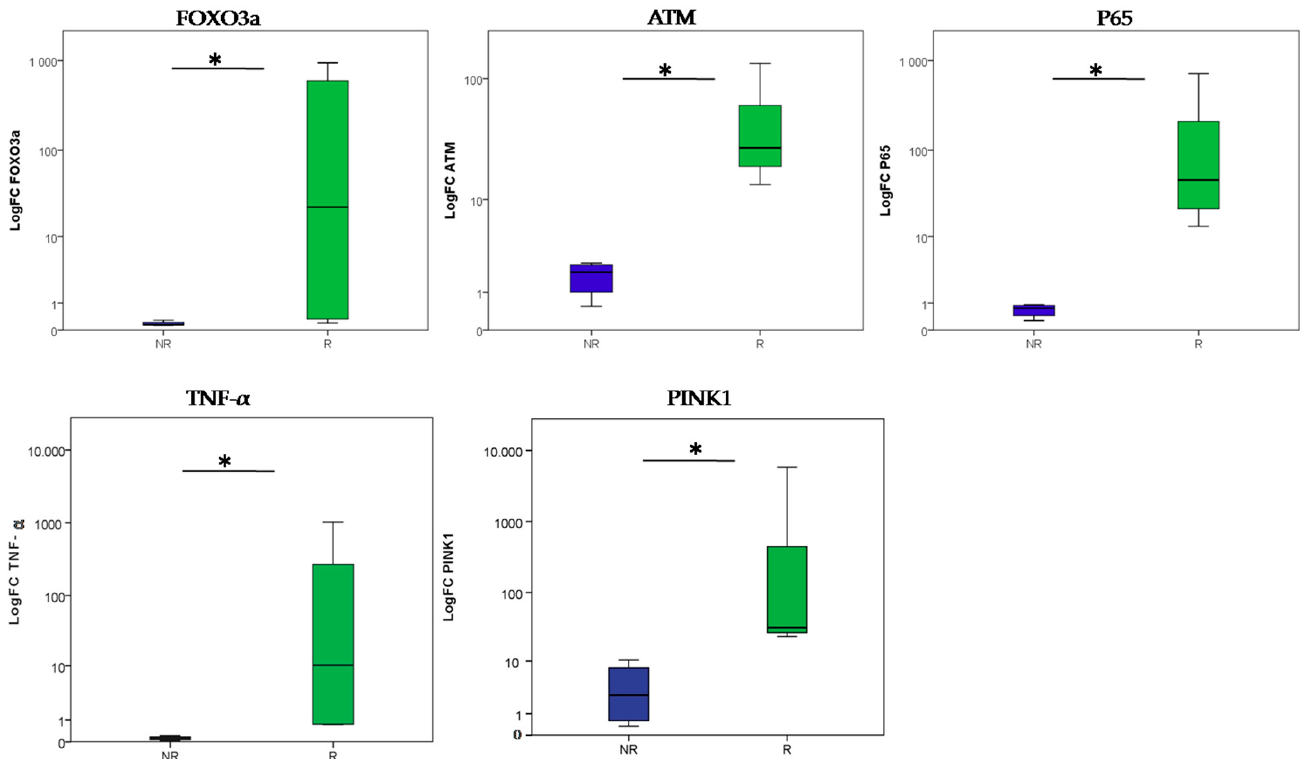
Figure 3. Differential gene expression profiles for radio-induced and non-radio-induced BCC biopsies. Blue box plot: non-radio-induced BCC (NR); green box plot: radio-induced BCC (R). (* = p < 0.05).